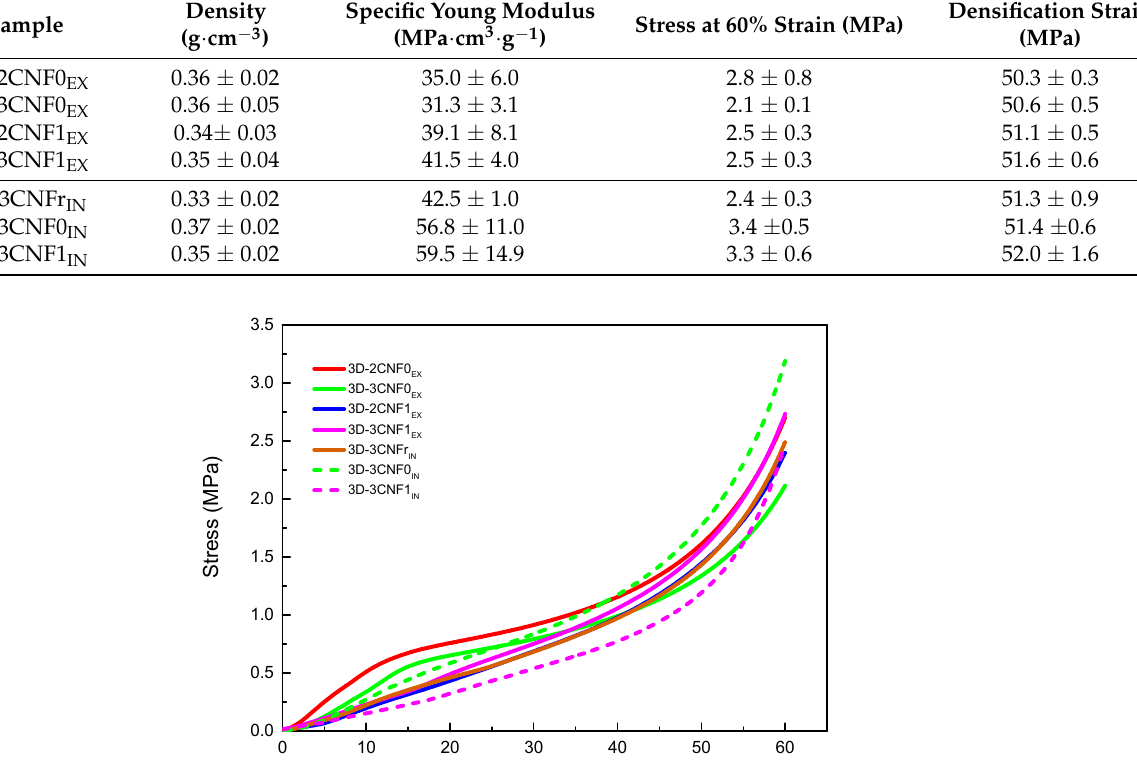
Table 5. Young modulus, specific Young modulus, stress at 60% strain and densification strain values for 3D-printed parts obtained from WBPUU/CNF inks.